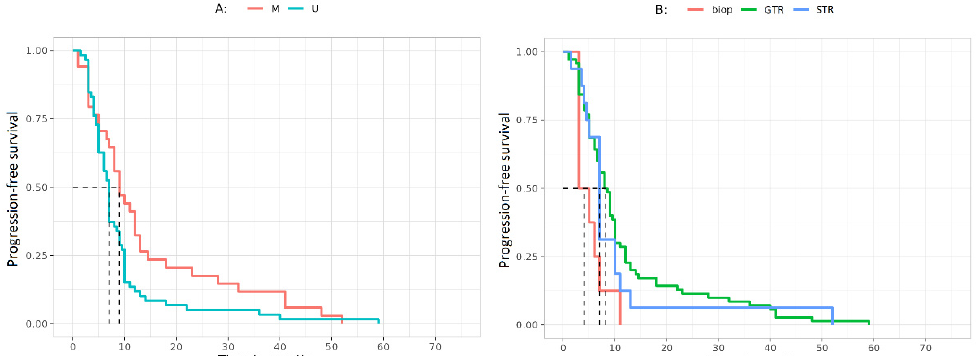
Figure 4. ( A ) PFS curves representing the survival of patients (in terms of months) on the basis of MGMT methylation status. Dashed vertical lines: median survival times (months) U: 7, M: 9. ( B ) PFS curves representing the survival of patients (in terms of months) on the basis of surgery type. Dashed vertical lines: median survival times (months) biop: 4, GTR: 8.25, STR: 7. Abbreviations: biop, biopsy; GTR, Gross Total Resection; M, methylated; PFS, progression-free survival; STR, Subtotal Tumor Resection; U, unmethylated.